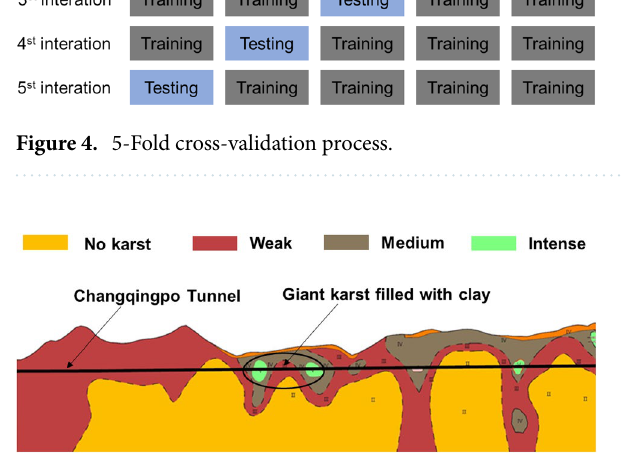
Figure 5. The main karst development of tunnel passing